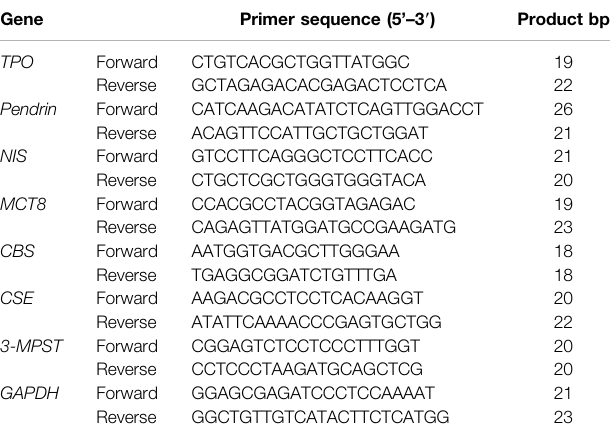
TABLE 1 | Primer sequences used for real-time